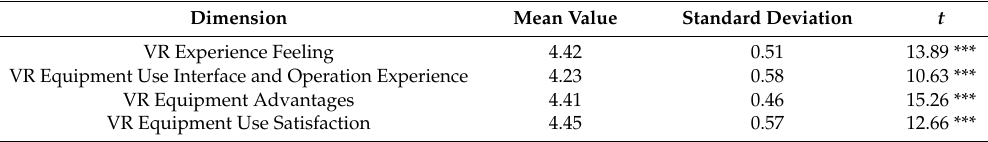
Table 9. Satisfaction analysis of VR equipment-assisted